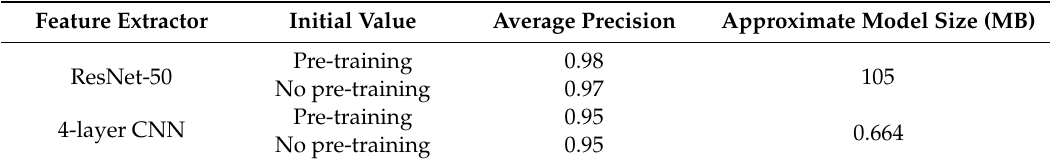
Table 3. Average precision of tree detection by the YOLO v2 detector. The feature extractor in the network was based on ResNet-50 and 4-layer CNN, as explained in the Section 2.5.2. The weight and bias were tuned for tree / non-tree classification, as shown in Section 3.2.1. The result with the network is denoted as “Pre-training”. In contrast, the result with no training, where the transferred ResNet-50 and 4-layer CNN with a randomly determined initial value were used, is represented by “No pre-training”. The approximate model size of the YOLO v2 detector using ResNet-50 and the 4-layer network in MATLAB is